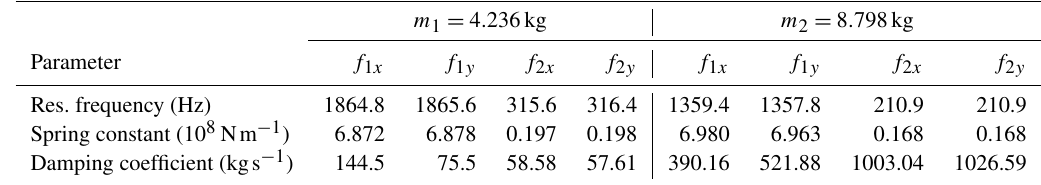
Table 2. Resonance frequencies, spring constants and damping coefficients for force excitation in x and y . m 1 = 4 . 236kg m 2 = 8 . 798kg